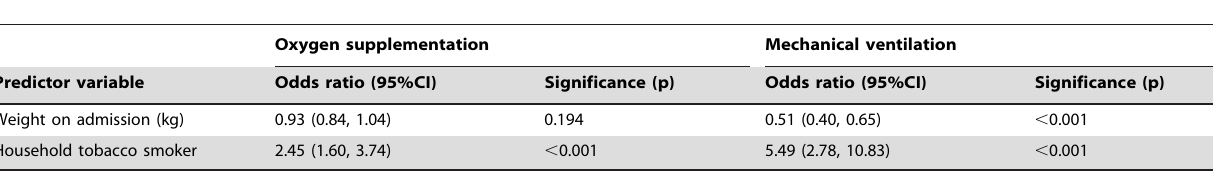
Table 2. Results of multivariate analysis; independent variables predicting severe bronchiolitis in 378 infants admitted to hospital.